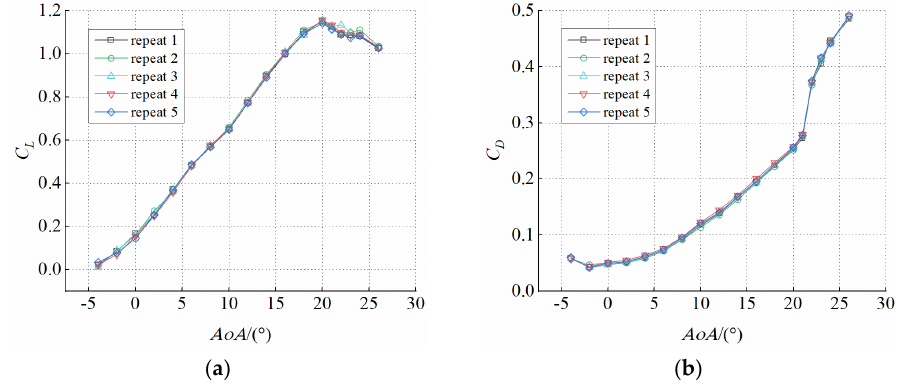
Figure 5. Results of repeated experiments. ( a ) Lift coefficient. ( b ) Drag coefficient.